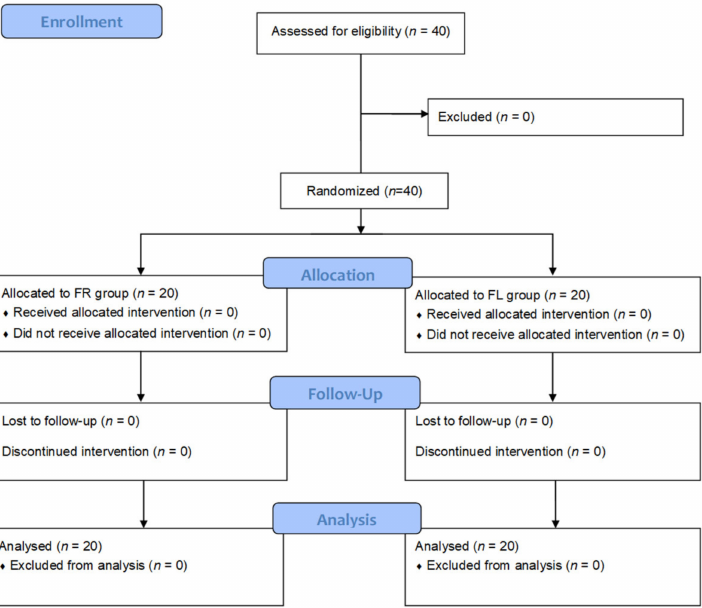
Figure 1. CONSORT flow diagram. FR group: flavonoid-rich orange juice group; FL group: flavonoid- low orange cordial